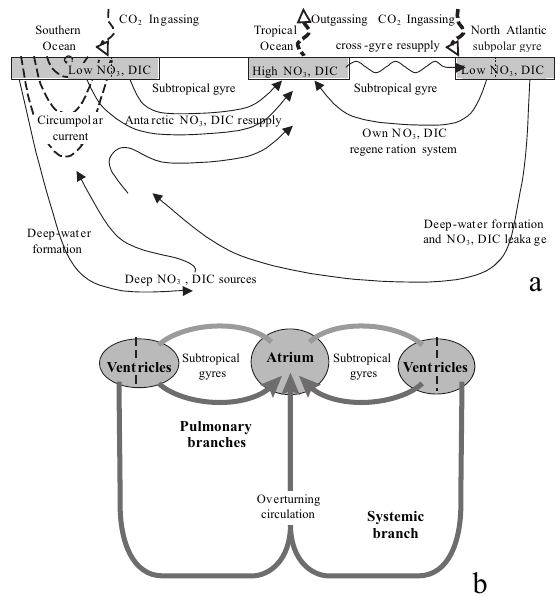
Fig . 3. – (a) Major mass, nutrient, and carbon pathways connecting the upper and deep oceans. Most deep water is formed at high lati- tudes in the atlantic, in what constitutes the start of the overturning circulation, and returns to the near-surface ocean in the antarctic shelf and equatorial regions. additionally, all subtropical gyres hold very efficient production-remineralisation processes in the upper- ocean recirculation. (b) Idealised physiological representation of the ocean circulation as an out-of-phase double-pump system, each pump containing three-chambers and sustaining a double-circuit. each pump flushes to an (almost) independent pulmonary circuit (upper ocean) and to one common systemic circuit (deep